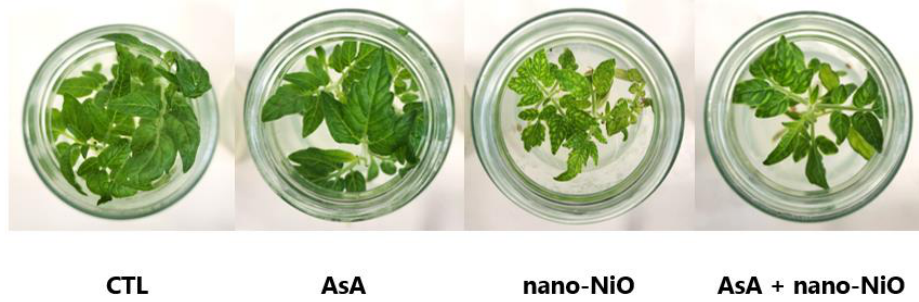
Figure 1. Effects of nickel oxide nanomaterials (nano-NiO; 30 mg L −1 ) and/or ascorbate (AsA; 150 mg L −1 ) on the length and biomass, expressed as fresh weight (f.w.), of roots ( A, B ) and shoots ( C, D ) of in vitro grown tomato plantlets. Data presented are mean ± SEM (n ≥ 3). Different letters above bars indicate significant statistical differences between treatments at p ≤ 0.05.